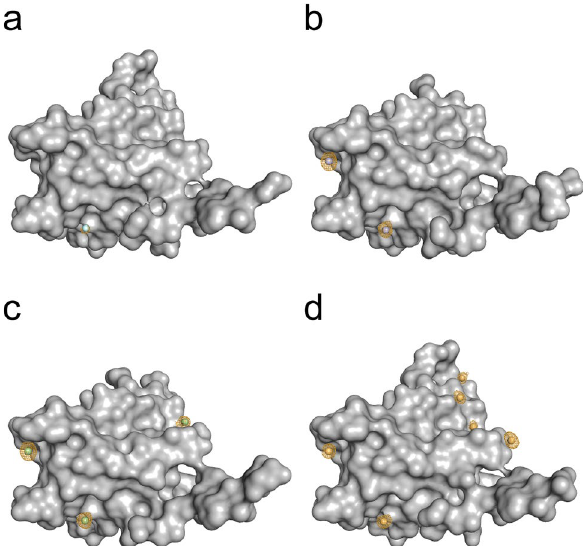
Figure 8. Cesium substructure of the p62 PH domain after supplementing with CsCl at different stages of the purification and crystallization process. P62 PH is represented as grey surface, cesium ions are represented as spheres. Orange meshes display the anomalous density contoured at 3 σ. ( a ) Dataset #2: Protein purified in CsCl-buffer. ( b ) Dataset #3: Protein purified in CsCl-buffer and supplemented with 0.25 M CsCl in the cryo- protectant solution. ( c ) Dataset #4: Protein purified in NaCl-buffer and supplemented with 0.75 M CsCl in the cryo-protectant solution. ( d ) Dataset #5: Protein purified in CsCl-buffer and supplemented with 0.75 M CsCl in the cryo-protectant solution.